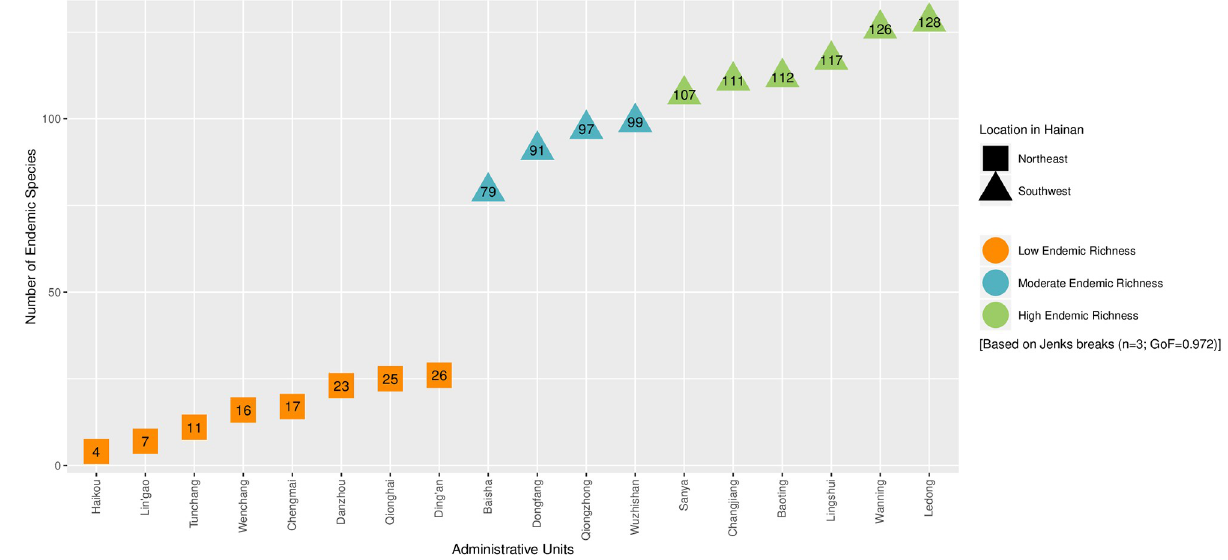
Fig 2. The number of endemic species in each administrative unit (city or county) of Hainan, China.